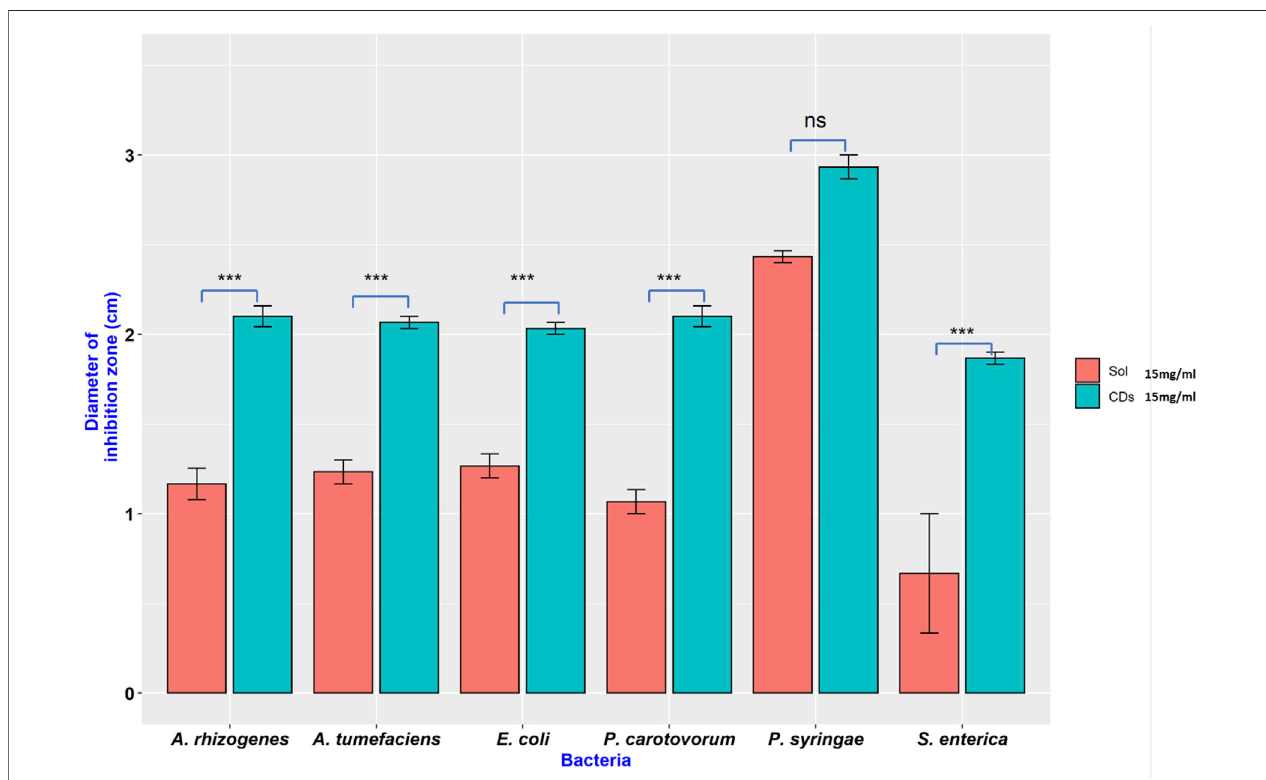
FIGURE 7 | Inhibition on different Gram-negative bacteria in the presence of NH2-CDs and its precursors (Sol). Ns (cid:2) no signi fi cant differences, *** (cid:2) signi fi cant differences at p ≤ 0.001.